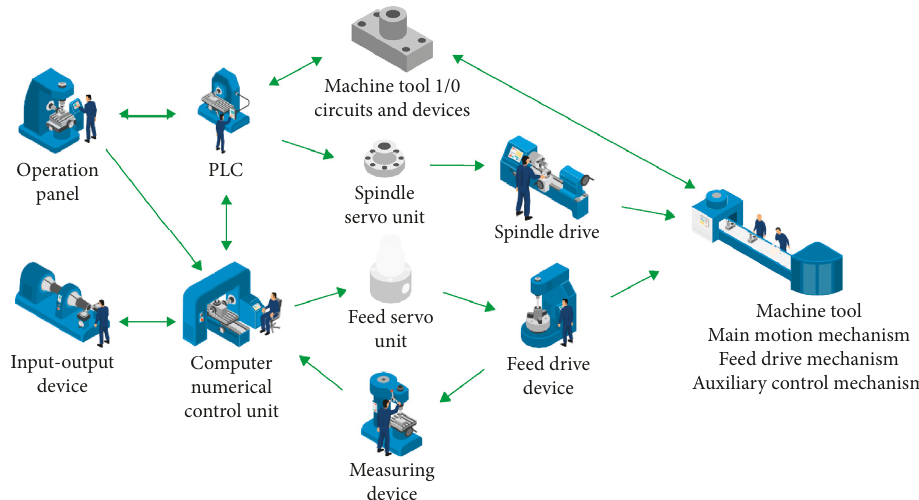
Figure 1: Cooperative control of the electrical system of the laser CNC machine tool.